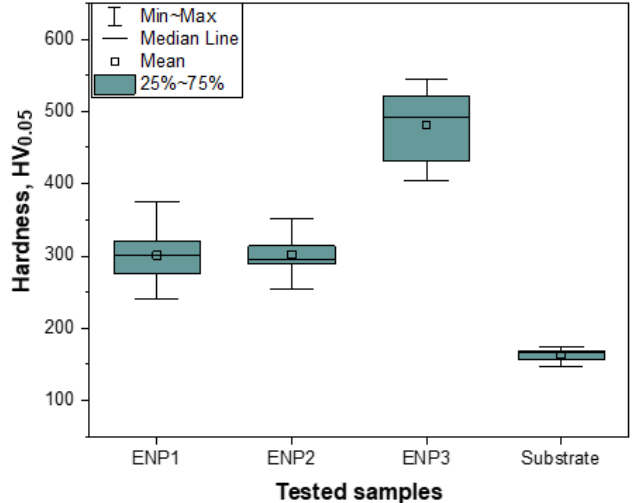
Figure 5. The effect of PTFE content on microhardness of the deposited ENP+PTFE: ENP1, ENP2 and ENP3 duplex coatings.